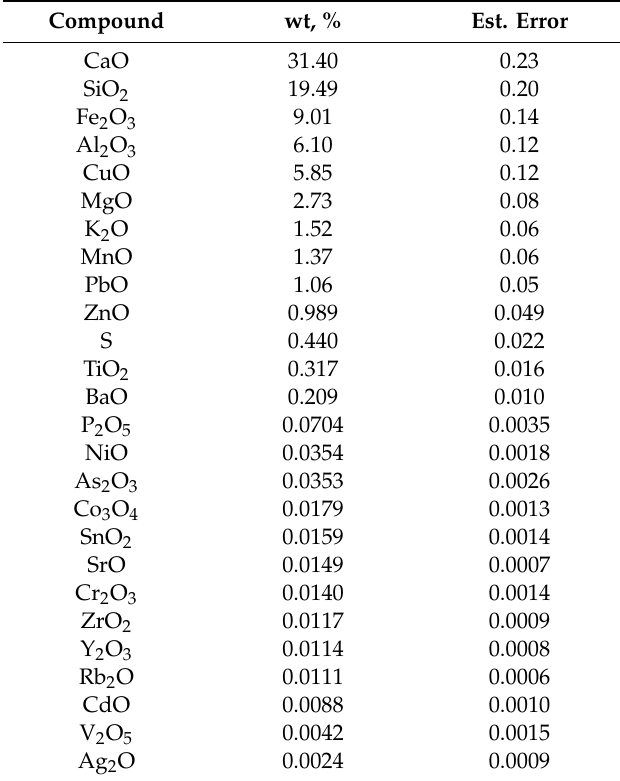
Table 2. X-ray fluorescence of the mining waste